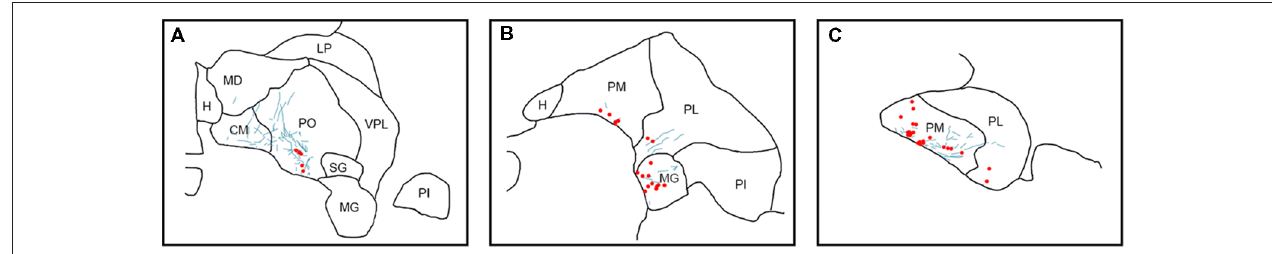
FIGURE 6 | Pattern of overlapping label in Case S2. Each panel (A–C) presents a plot of labeled cell bodies or fibers from different rostro-caudal levels through the pulvinar. Anterograde label (putative axons) after injection of FE in the SC are shown in cyan. Retrograde label (cell bodies) after injection of CTB in the amygdala are shown in red. Abbreviations for thalamic nuclei are as in Figure 1 .